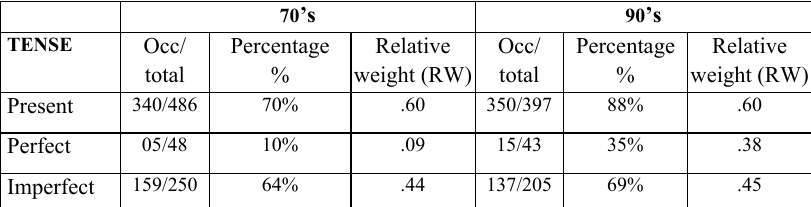
Table 1 – Frequency and Relative Weight of the use of ter (NURC